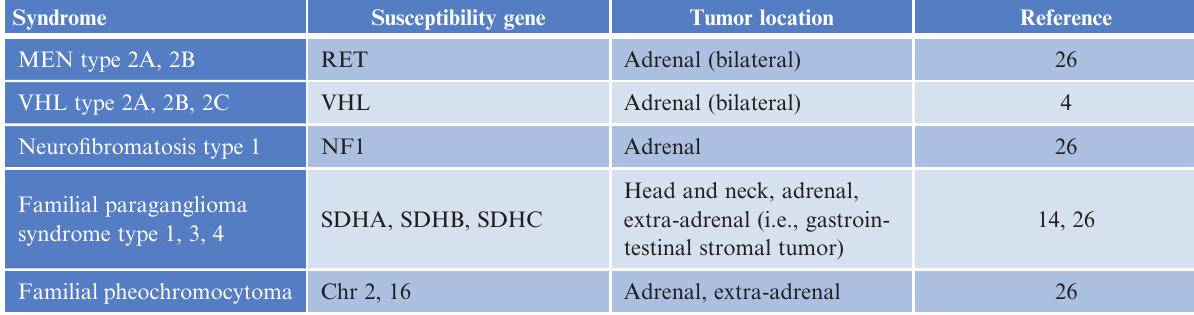
Table 4. Hereditary syndromes and subtypes of pheochromocytoma